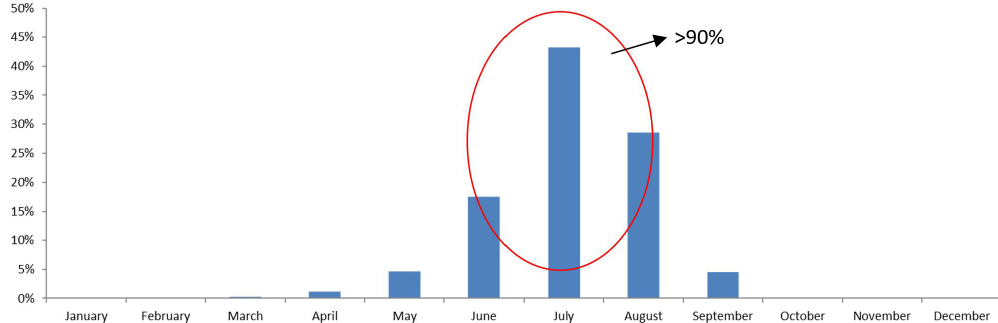
Figure 2. The proportion distributions of hot days in 12 months from 1955 to 2014 in 31 capital cities in